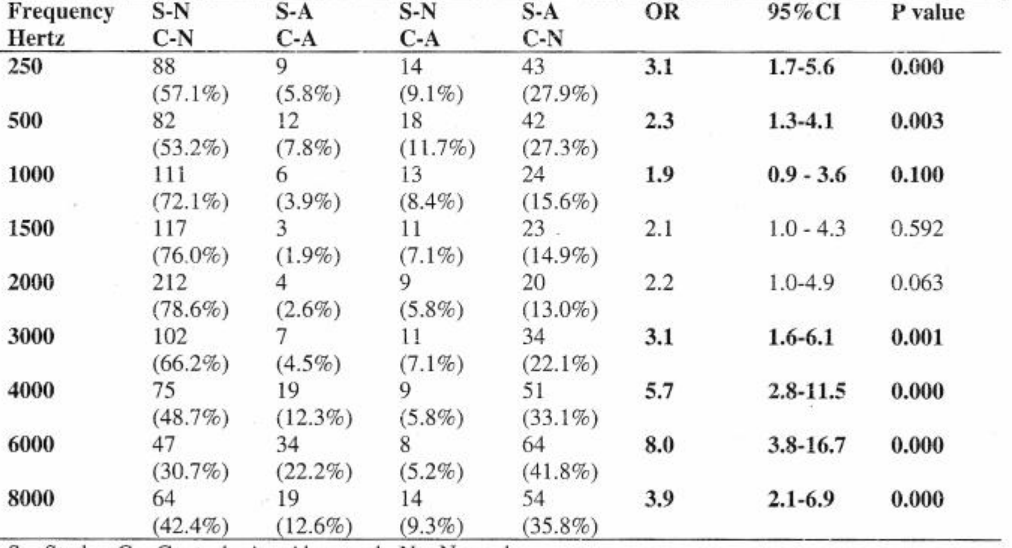
Table 3 : Impairment Of Hearing By Frequency - Right Ear